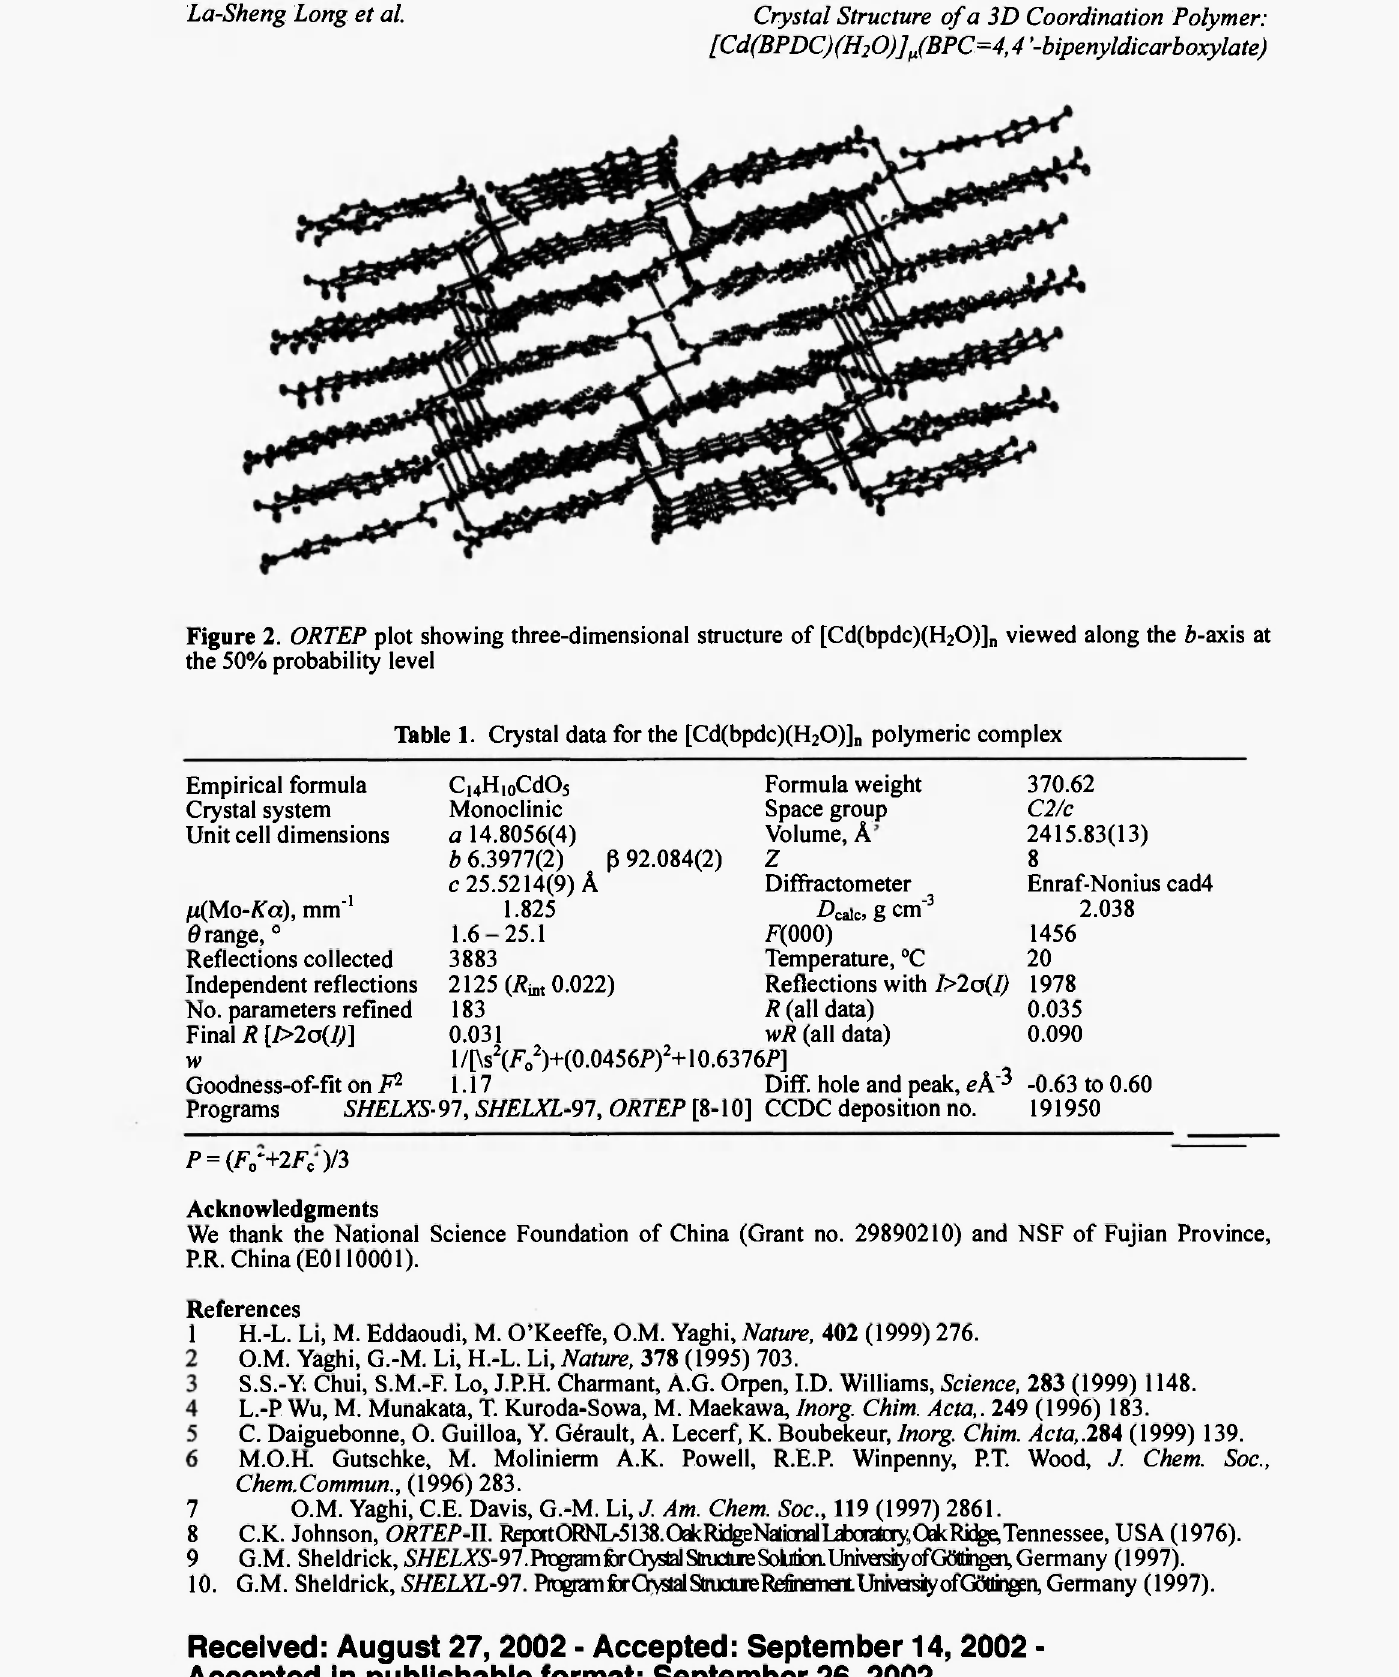
Figure 2. ORTEP plot showing three-dimensional structure of [Cd(bpdc)(H 2 0)]„ viewed along the b- axis at the 50% probability level Table 1. Crystal data for the [Cd(bpdc)(H 2 0)]„ polymeric